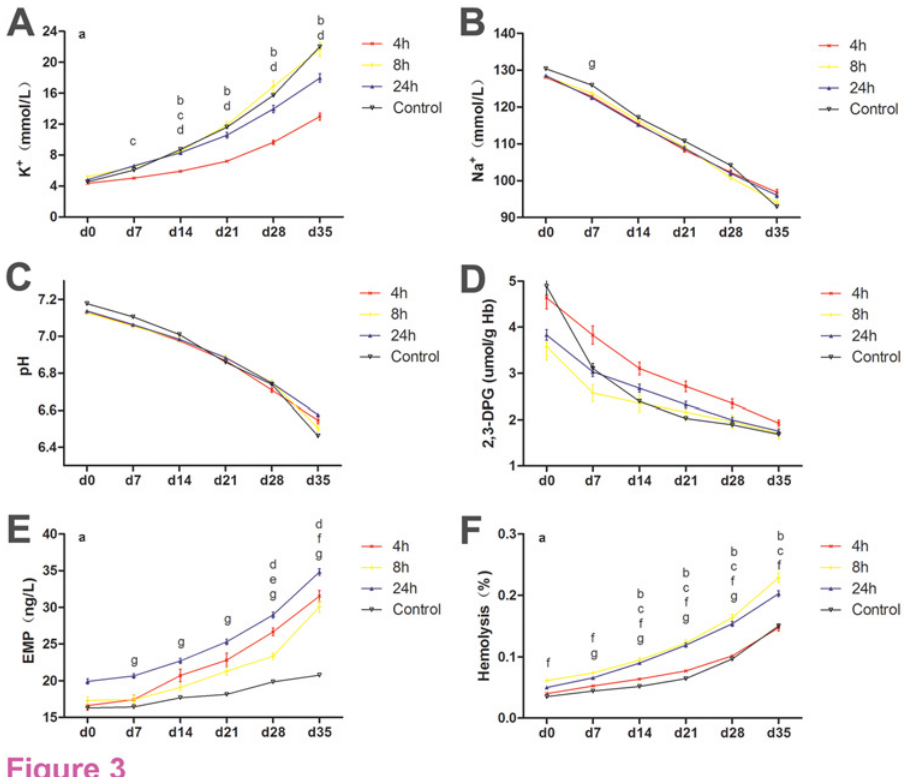
Fig 3. Major characteristics of UC-RBCs in vitro. A . Changes in K + concentration over time during storage at 4°C; B . Changes in Na + concentration over time during storage at 4°C; C . Changes in pH over time during storage at 4°C; D . Changes in 2,3-DPG over time during storage at 4°C; E . Changes in EMP over time during storage at 4°C; F . Changes in the percent of hemolysis over time during storage at 4°C. a: p < 0.05, comparison of between-subjects effects; b: p < 0.05, pairwise comparison at the same time point between 4 h and 8 h group; c: p < 0.05, pairwise comparison at the same time point between 4 h and 24 h group; d: p < 0.05, pairwise comparison at the same time point between 4 h and control group; e: p < 0.05, pairwise comparison at the same time point between 8 h and 24 h group; f: p < 0.05, pairwise comparison at the same time point between 8 h and control group; g: p < 0.05, pairwise comparison at the same time point between the 24 h and control